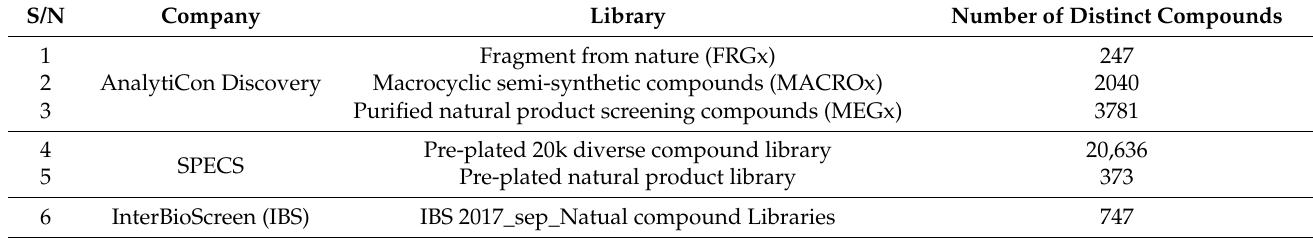
Table 1. Summary of natural product compound libraries used for virtual screening.